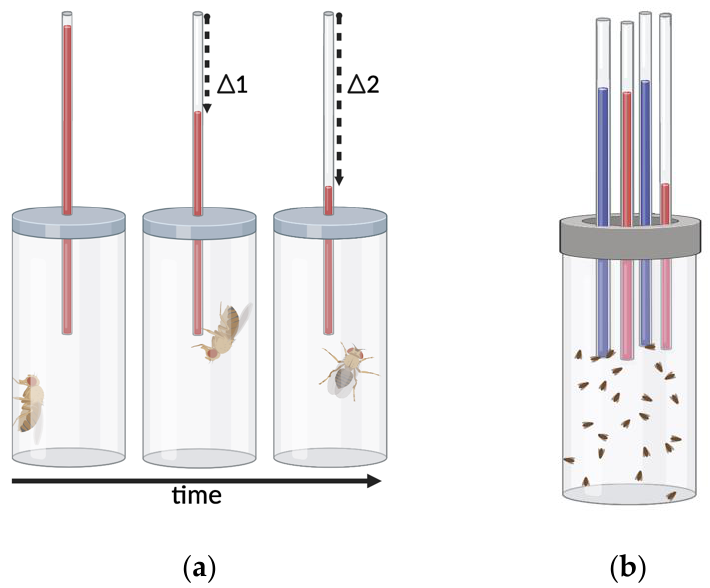
Figure 4. Assays used to measure psychostimulant consumption and preference in Drosophila ( a ) A single-fly assay of voluntary consumption where the rate of consumption is determined by monitoring displacement of the solution over time. The black dashed lines represent the cumulative change in volume recorded at the first and second measurement timepoints. ( b ) Flies housed in a Multiple Capillary Feeder (MultiCAFE) Assay with access to two different feeding solutions, depicted here as red and blue. The consumption of each solution over time is determined by monitoring the displacement the meniscus in each capillary. Data are used to characterize rate of consumption, cumulative consumption, and preference. Created with BioRender.com.